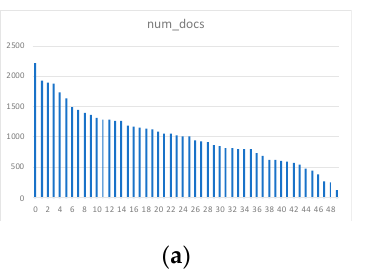
Table 10. Experimental results of clustering model selection. All the results were obtained with sentence-t5-xxl as the sentence embedding model and 50 as the number of topics.